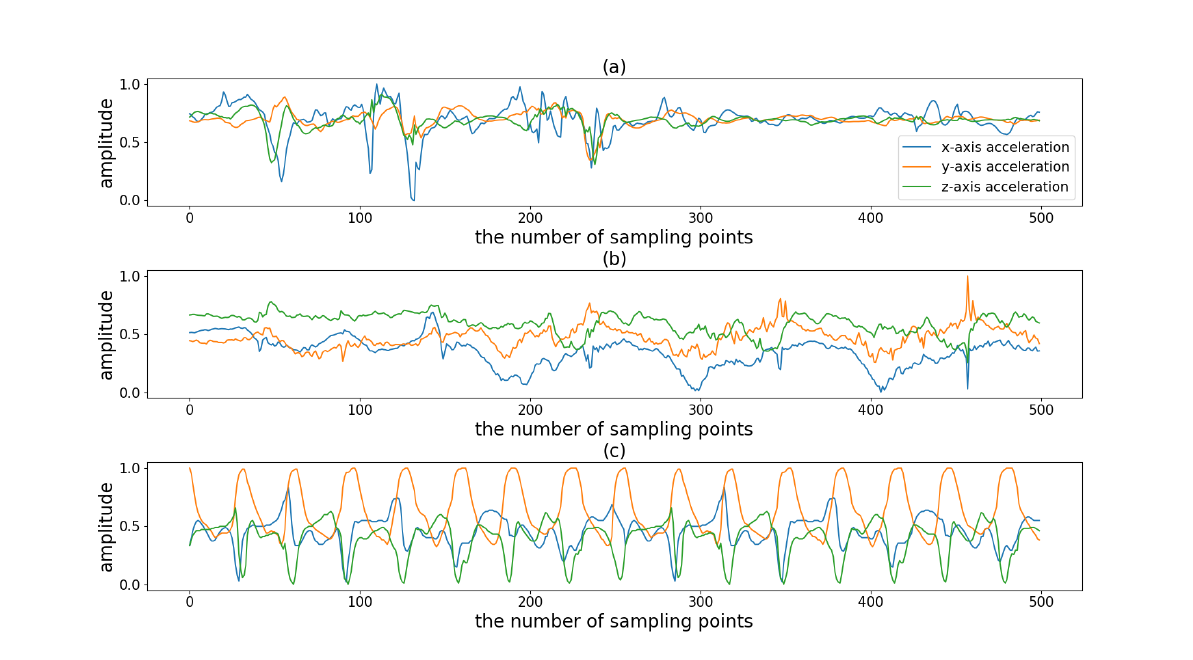
Figure 1. Illustration of triaxial acceleration of three kinds of sports: ( a ) the waveform of playing badminton, ( b ) the waveform of swimming, and ( c ) the waveform of